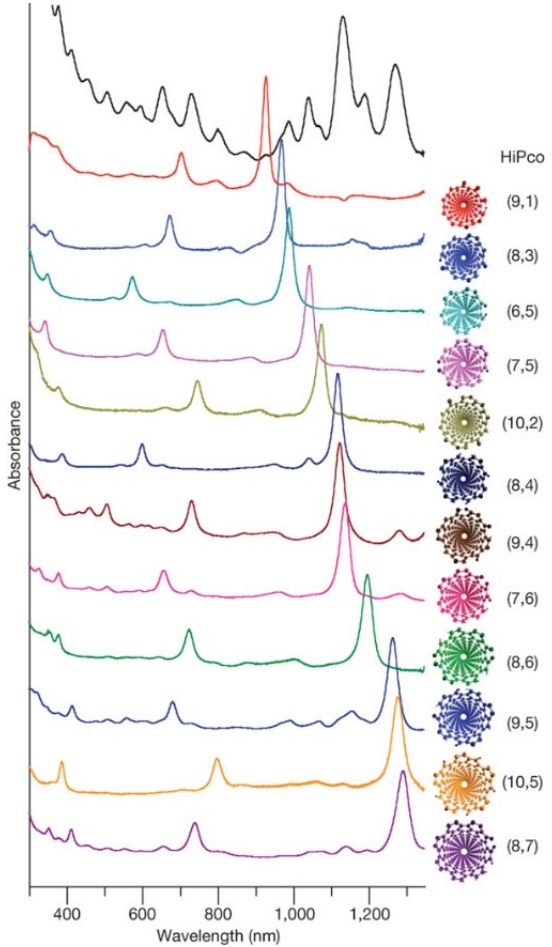
Figure 2. Optical absorption spectra of separated SWNTs by selective adsorption of ssDNA, reported by Tu et al. (Reprinted from reference [91] with